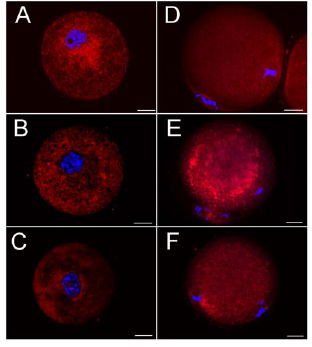
Figure 4. Effect of MG and resveratrol treatment on ROS in oocytes. MI-stage oocytes were incubated in M2 medium plus 0.1% DCFH diacetate (DCFH-DA) for 30 mins. The Effect of MG and resveratrol on ROS production can be measured by the DCFH fluoresence. ( A ) Control group; ( B ) and ( C ) MG-treated group; ( D ) RSVL-MG-treated group. Arrows show the cortex of oocytes with high level of ROS. Scale bar =20 m m.